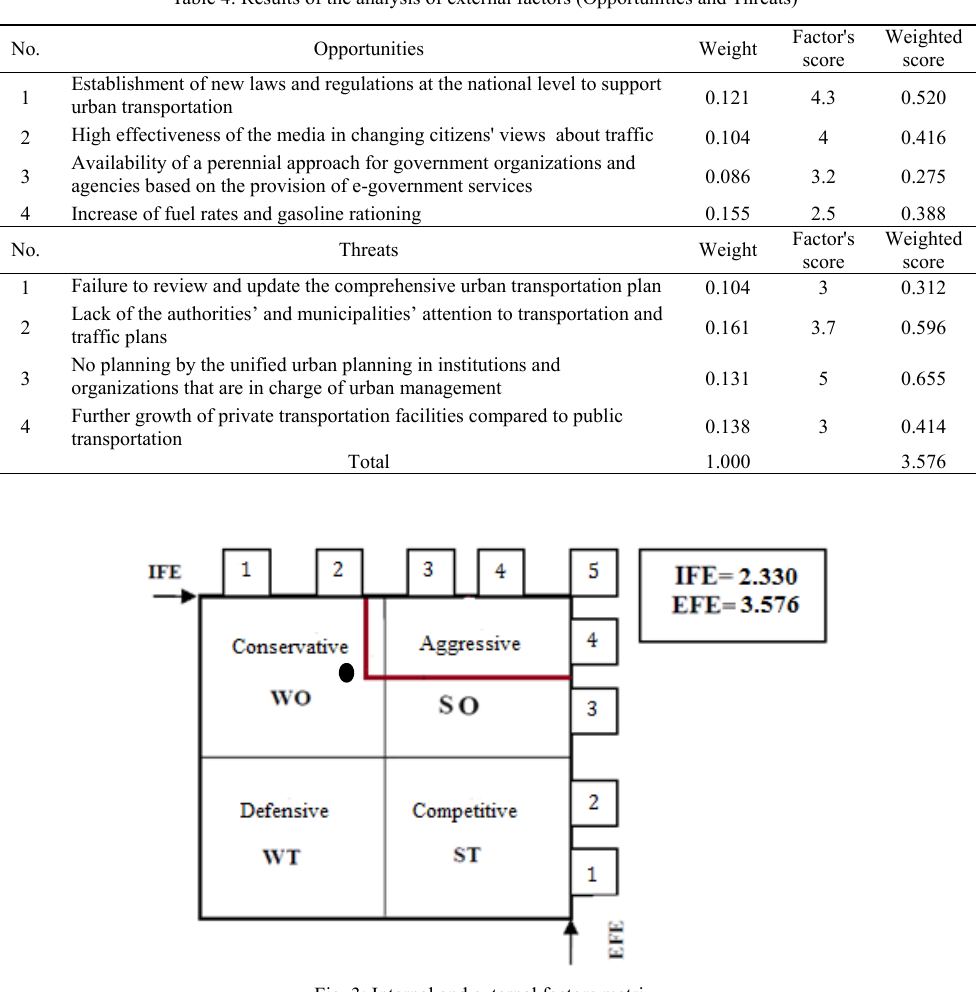
Table 4: Results of the analysis of external factors (Opportunities and Threats)